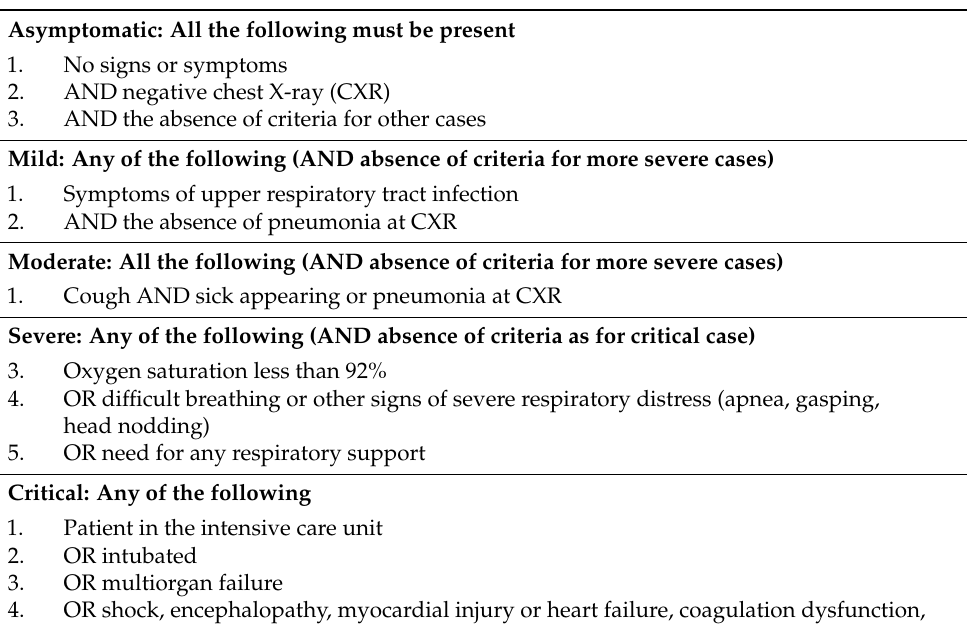
Table 1. Disease severity score described by Parri (adapting a previous classification)